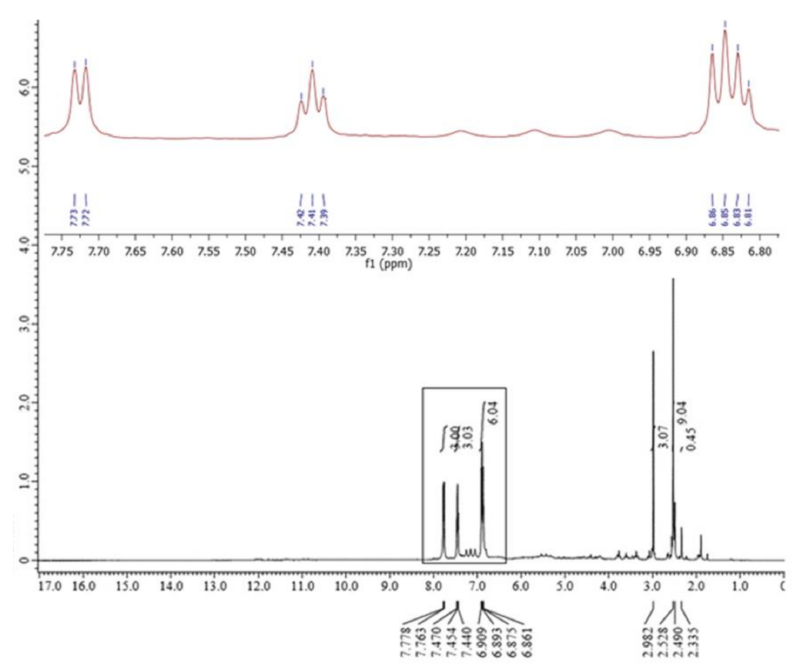
Figure 1. 1 H-NMR characterization of